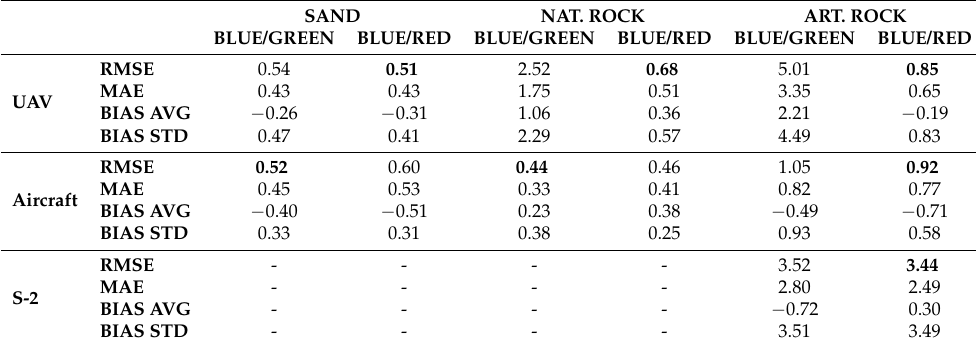
Table 5. RDB statistical parameters (in m) for each platform (UAV, aircraft and S-2): RMSE and MAE for the model validation and AVG and STD BIAS between the RDB and the GPs for the two bands ratios for each seabed class (sand, artificial and natural rocks). Portosole overlap